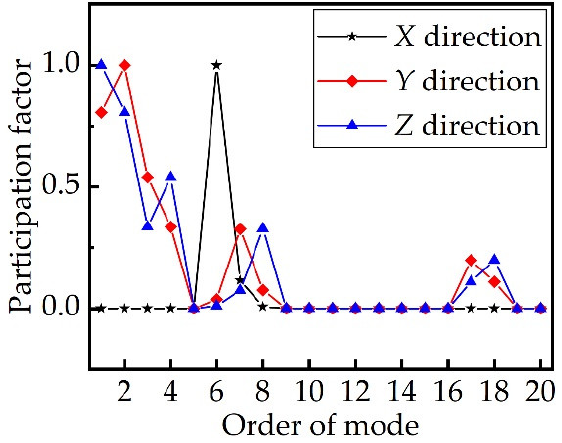
Figure 24. Participation factor of each mode in different direction.